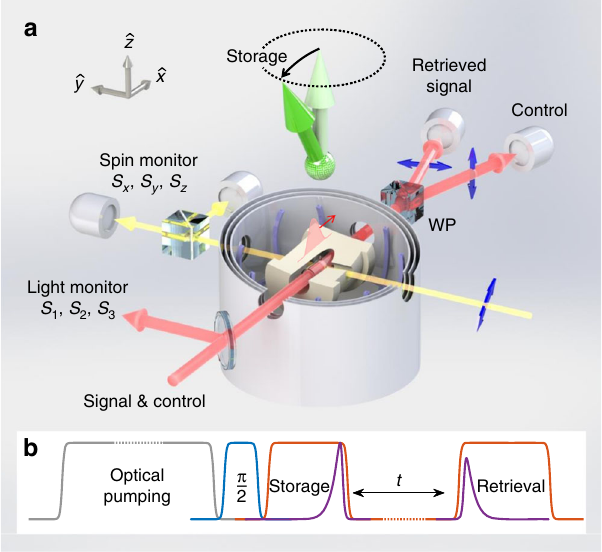
Fig. 2 Experimental setup and sequence. A cylindrical vapor cell with diameter 10 mm and length 30 mm is held inside a hot-air oven ( a , beige), enclosed by three Helmholtz coil pairs and magnetic shield layers. First, optical pumping ( b , gray) is done along ^ x using two circularly-polarized beams (not shown in a ) for the two hyper fi ne sublevels. Subsequently, a π /2 pulse of magnetic fi eld along ^ y ( b , blue) prepares a spin ensemble oriented along ^ z ( a , light green arrow). The control and incoming signal ( a , red beam) are sampled before the cell to monitor their polarization state. Storage and retrieval of a signal pulse ( b , purple) is done by turning off and then on the control ( b , red). The light state is stored onto the orientation of the tilted spin polarization ( a , dark green arrow), which can be monitored with auxiliary far-detuned light ( a , yellow beam). The retrieved signal is separated from the control using a high extinction-ratio Wollaston prism (WP). Blue arrows in a indicate optical (signal + control) fi eld. This polarization is visualized on the Poincaré sphere using the Stokes parameters S 1 , S 2 , S 3 in Fig. 4c.